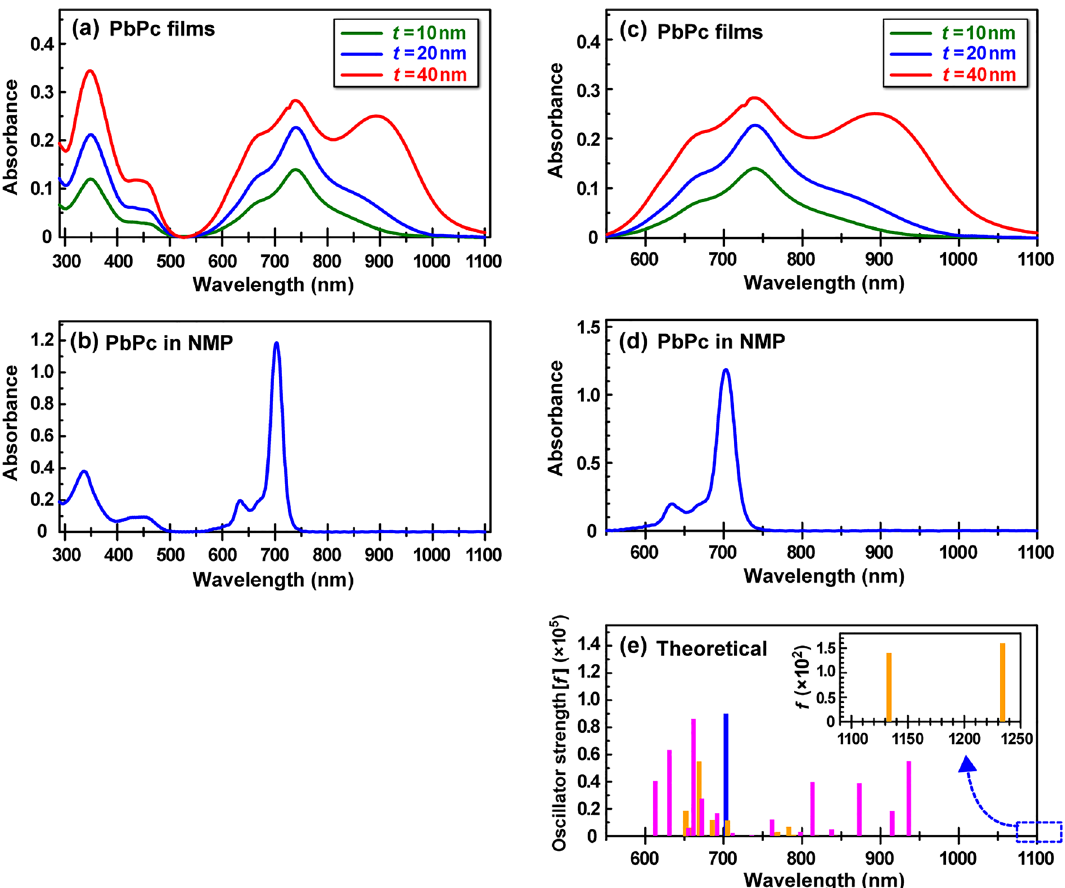
a quartz cell, ( c,d ) the magnified Q-band spectra of (a) and (b), and ( e ) theoretical absorption stick spectra of PbPc isolated molecule (blue) and the monoclinic (yellow)/triclinic (pink) tetramer models (see Fig. 4).